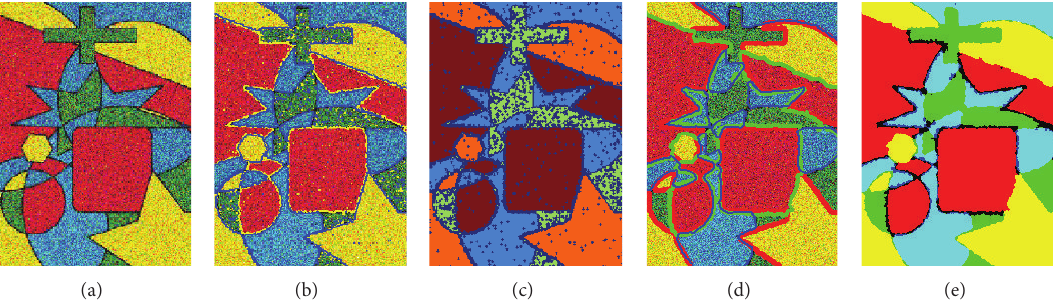
Figure 6: Results for a synthetic image added with Gaussian noise with 0 mean and variance 0.05 using the multiphase vectorial CV model and the proposed model; (a) original noisy image; (b) the corresponding final contours of the multiphase vectorial CV model; (c) the corresponding final labeled image of the multiphase vectorial CV model; (d) the corresponding final contours of the proposed model; (e) the corresponding final labeled image of the proposed model.